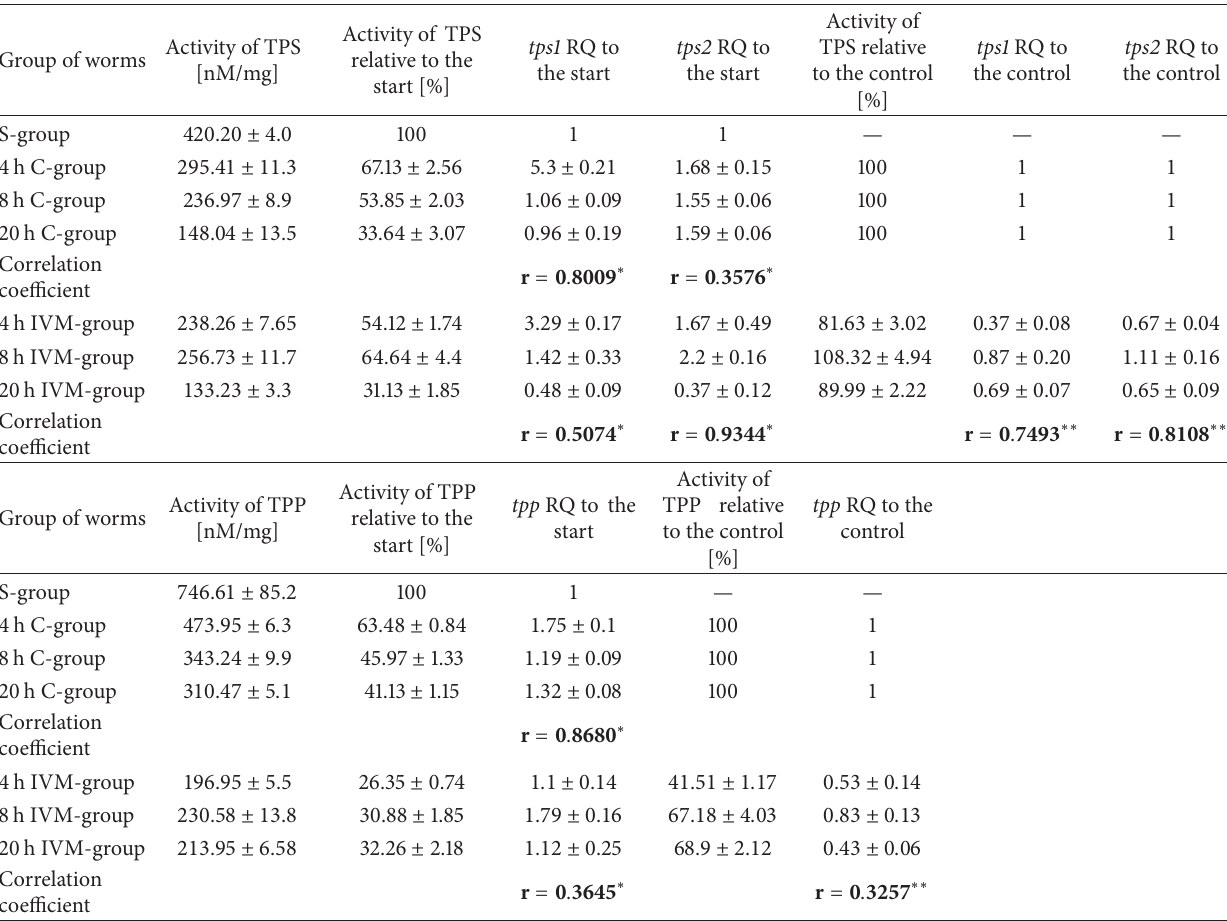
Table 2: Activity of trehalose-6-phosphate synthase (TPS) and phosphatase (TPP) and their mRNA expression ( tps1 , tps2, and tpp genes) during in vitro cultivation of adult female Ascaris suum in control (C-group) and ivermectin-supplemented medium